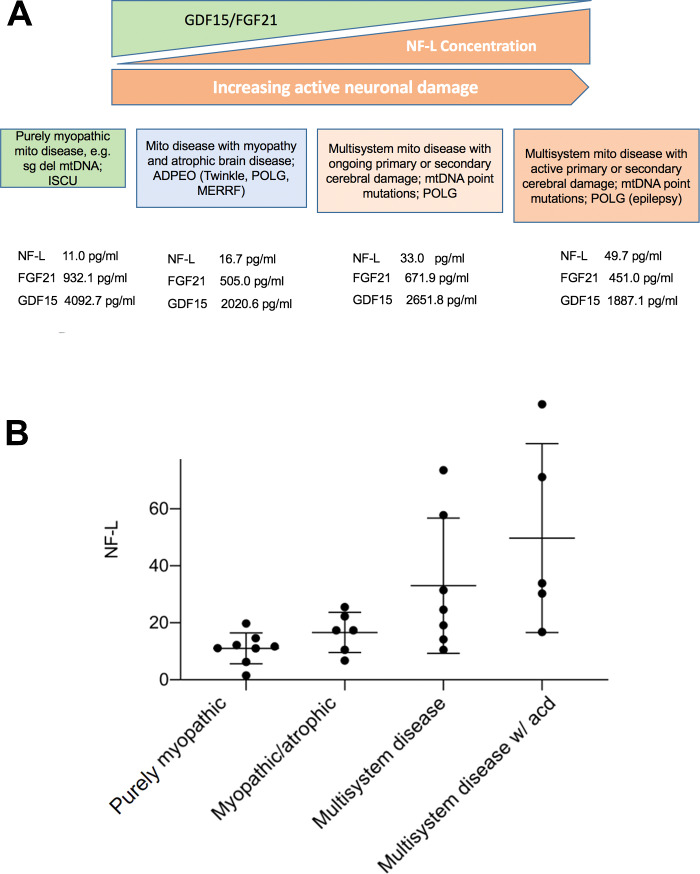

The biomarkers ability to differentiate clinical groups. There is a reciprocal trend in NF-L to FGF-21 and GDF-15, here illustrated by sub-classifying the patients by degree of CNS involvement. Brain involvement was sub-divided into slowly progressive atrophy, neurodegenerative disease with ongoing neuronal loss and conditions in which there would be more acute neuronal loss due to ongoing seizures or ischaemic damage (acd, active cerebral damage). The differences are most pronounced when looking at NF-L. (B) The differences between the clinical groups defined in (A) are significant (P = 0.012).